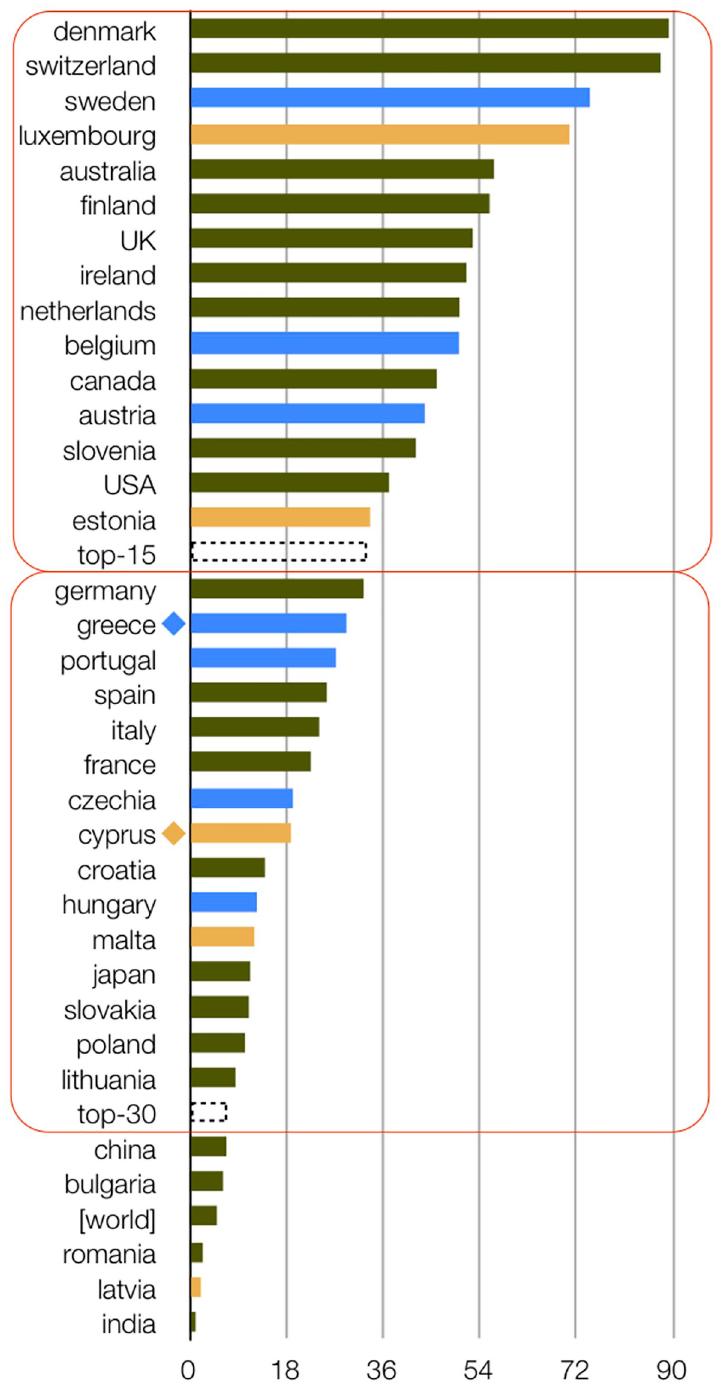
Fig 2. Output of publications per country (EU28 + 7 other countries), per million inhabitants. The 2 groups defined herein are marked by rectangles in a red outline. Greece is highlighted by a blue diamond and Cyprus by an orange diamond; countries with similar population to Greece (in blue) or Cyprus (in orange) are shown for comparison. Top-15 ( > 33 PpM), top-30 ( > 7 PpM), and world average (5 PpM, in square brackets) are also shown. EU28, European Union 28; PpM, publications per